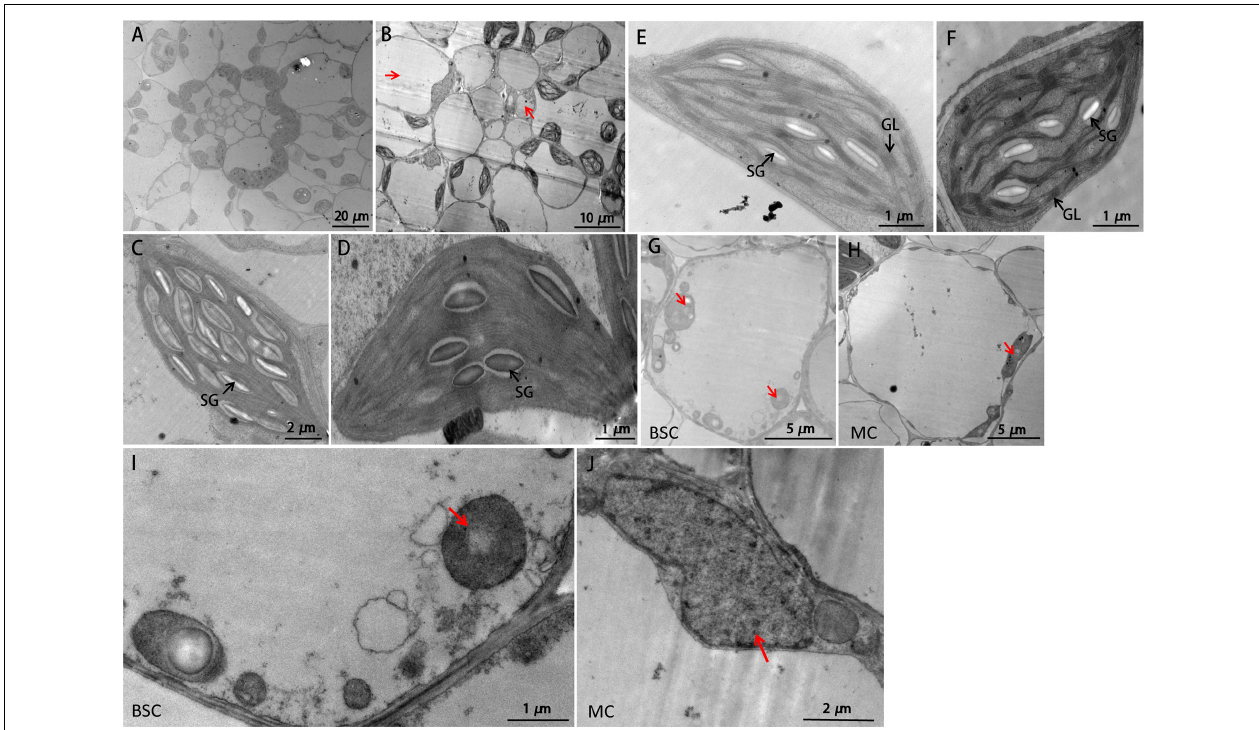
FIGURE 3 | TEM images of WT and sistl2 . (A,B) Kranz structures of Yugu1 and sistl2 , respectively. Red arrows, abnormal BSCs and MCs. (C,E) The chloroplasts in BSC and MC of Yugu1, respectively. The structure of an individual BSC chloroplast (WT) was shown in Supplementary Figure R2 . (D,F) The chloroplasts in normal BSC and MC of sistl2 , respectively. SG, starch granules; GL, grana lamella. Abnormal BSC (G) and MC (H) in sistl2 . Red arrows show the undeveloped chloroplasts. (I,J) Undeveloped chloroplast in BSC and